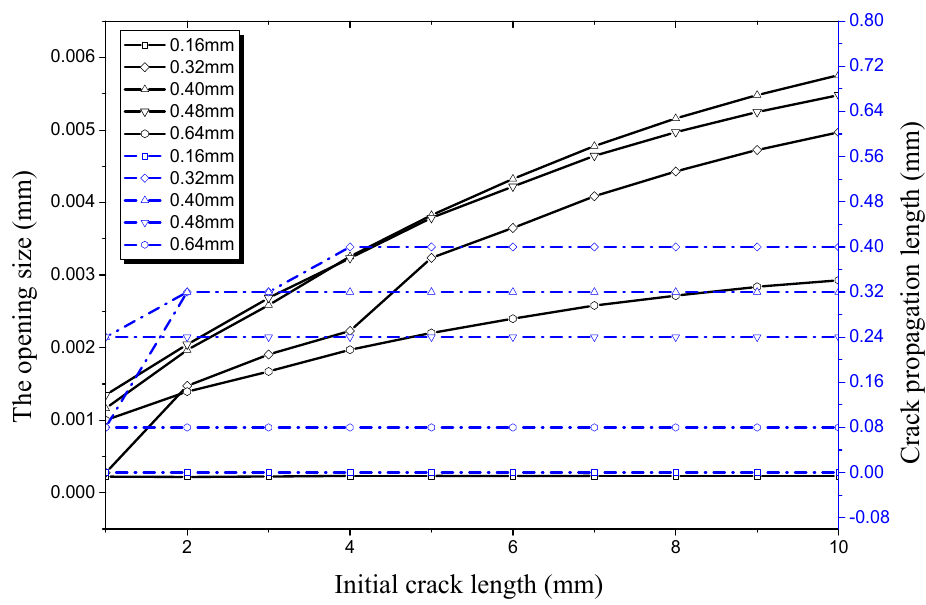
Figure 19. Relationship between radial crack propagation length and initial crack length on the outer surface, and relationship between radial opening size and initial crack length on the outer surface, both under an internal pressure of 35 MPa.